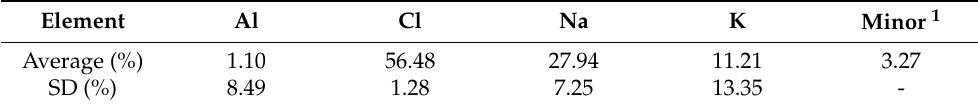
Table 4. Major element concentration (weight %) in the recovered salt. Element